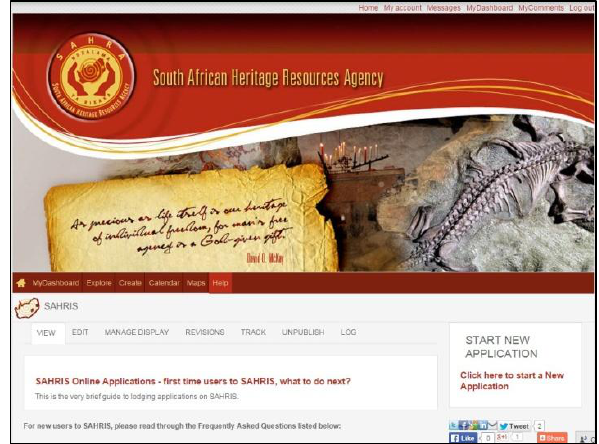
Figure 1: SAHRIS landing page at